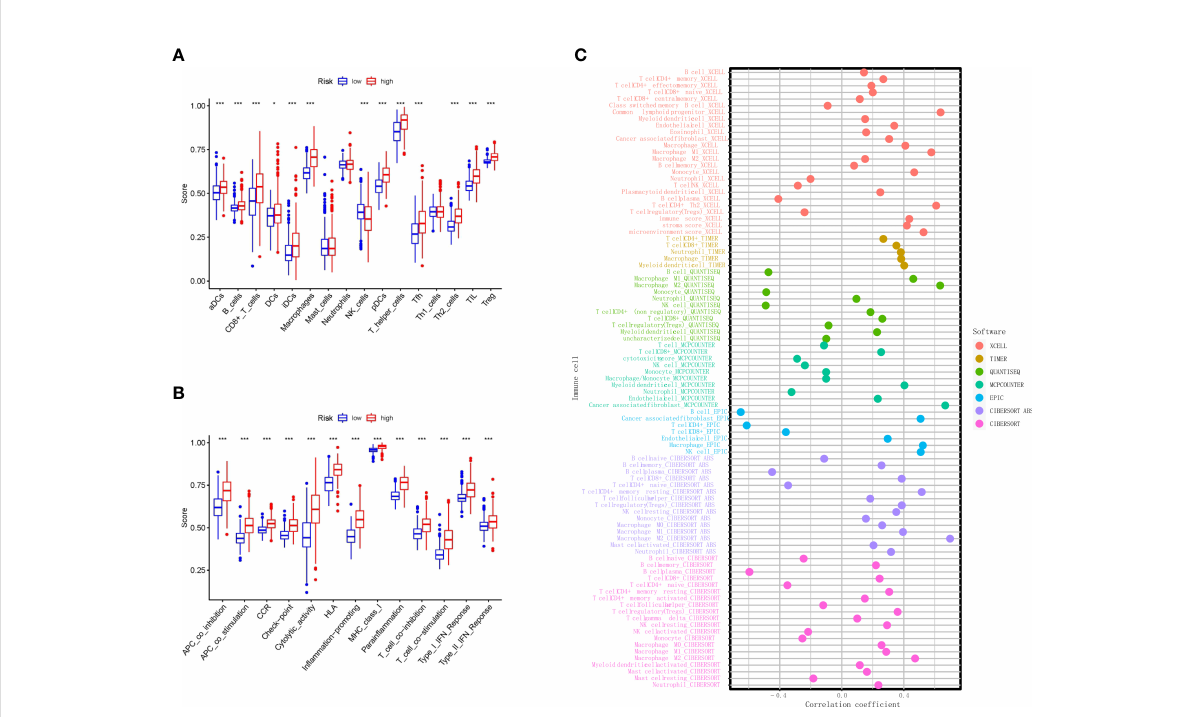
FIGURE 6 Immune algorithms employed in comparison based on nine necroptosis-related lncRNAs between the two risk groups in TCGA. (A) Comparison of the ssGSEA scores of nine necroptosis-related lncRNAs for immune cells in TCGA. (B) Comparison of the ssGSEA scores of nine necroptosis- related lncRNAs for immune-related pathways in TCGA. (C) Bubble graph for the in fi ltration levels of immune cells under XCELL, TIMER, QUANTISEQ, MCPCOUNTER, EPIC, CIBERSOFT ABS, and CIBERSOFT algorithms. **p < 0.01, and ***p < 0.001. lncRNAs, long non-coding RNAs; TCGA, The Cancer Genome Atlas; ssGSEA, single-sample Gene Set Enrichment